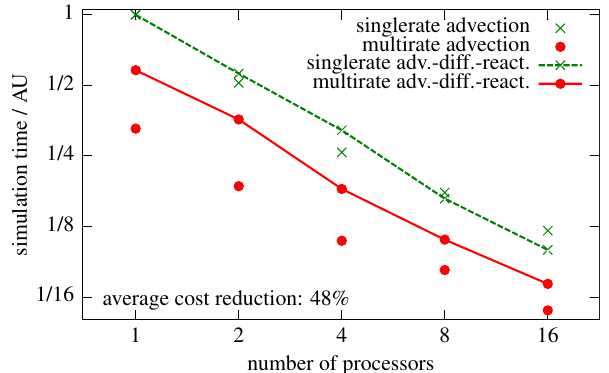
Fig. 7. Computational cost for academic test case. The displayed simulation time was normalised such that the single-rate setup on one processor corresponds to unit. Actual computational cost of the pure advection setup is about 1% of the full setup.